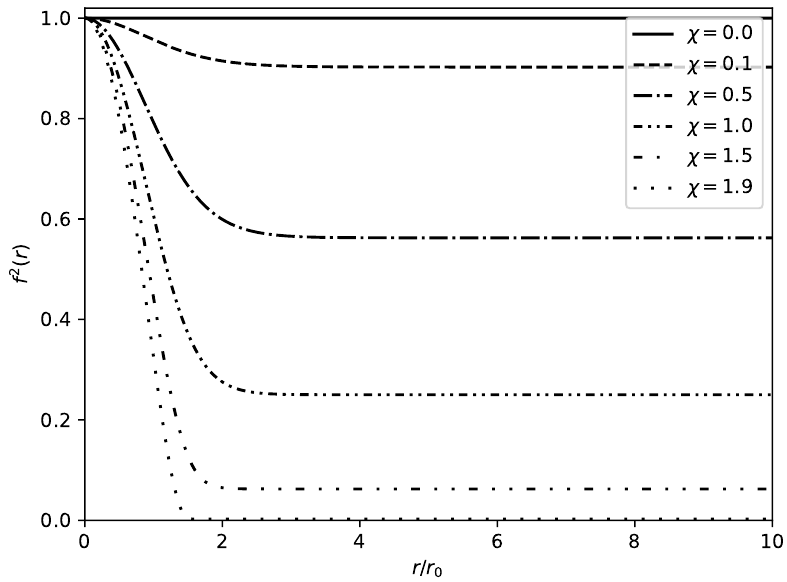
Figure 3 . Metric component of the non-singular self-gravitating Abrikosov vortex of vorticity N = 1 for increasing values of the “strength of gravity” χ = 16 πGv 2